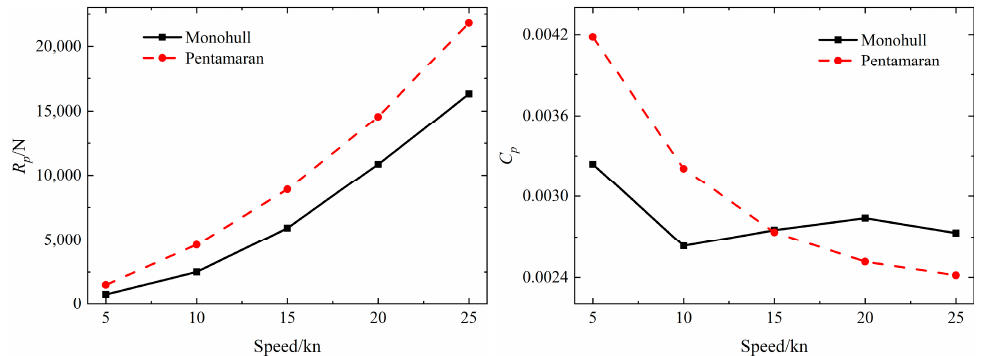
Figure 14. R p and C p curves.